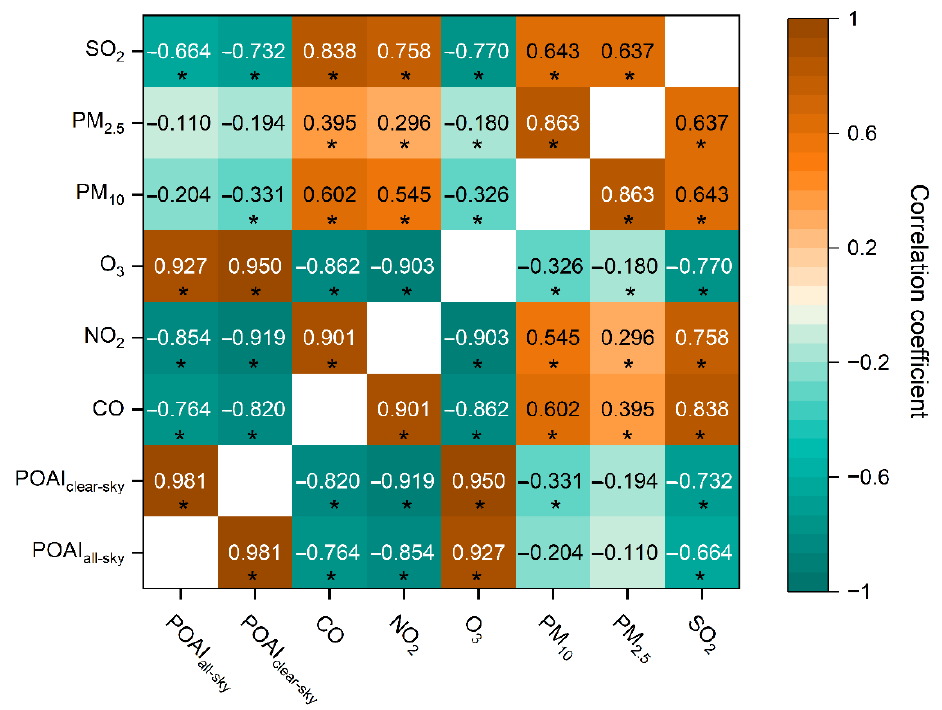
Figure 10. Correlation coefficients between POAI and surface concentrations of six air pollutants. The symbol * indicates that it passed the 95% significance test. Table 2. The global bivariate Moran Index of clear-sky POAI and surface concentrations of six air pollutants.